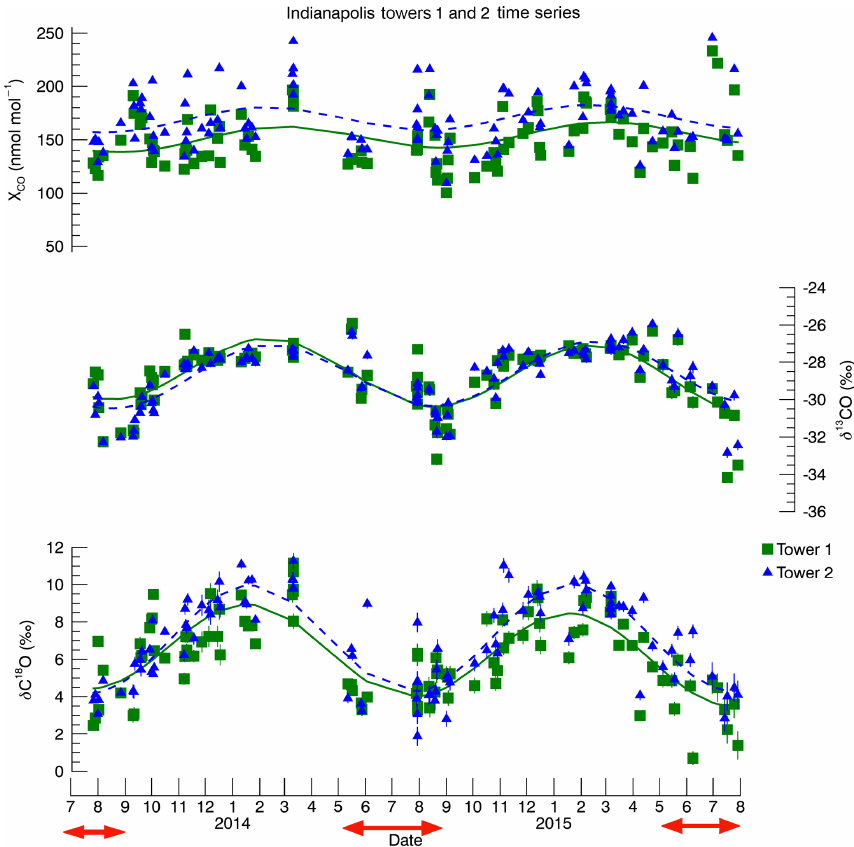
Figure 3. Time series of towers 1 and 2 at Indianapolis. These data were previously shown in Vimont et al. (2017) but are reproduced here for the convenience of the reader. The curves shown are for sighting purposes only. They are a simple single harmonic polynomial smoothing and are meant to aid the reader in viewing the seasonal variability. The error bars represent 1 σ uncertainty. CO mole fraction 1 σ uncertainty is ± 0.5nmol:mol. The red arrows indicate the time periods used in this study, and these data, along with δ 13 C and δ 18 O 1 σ uncertainty, are listed in the Supplement (Table